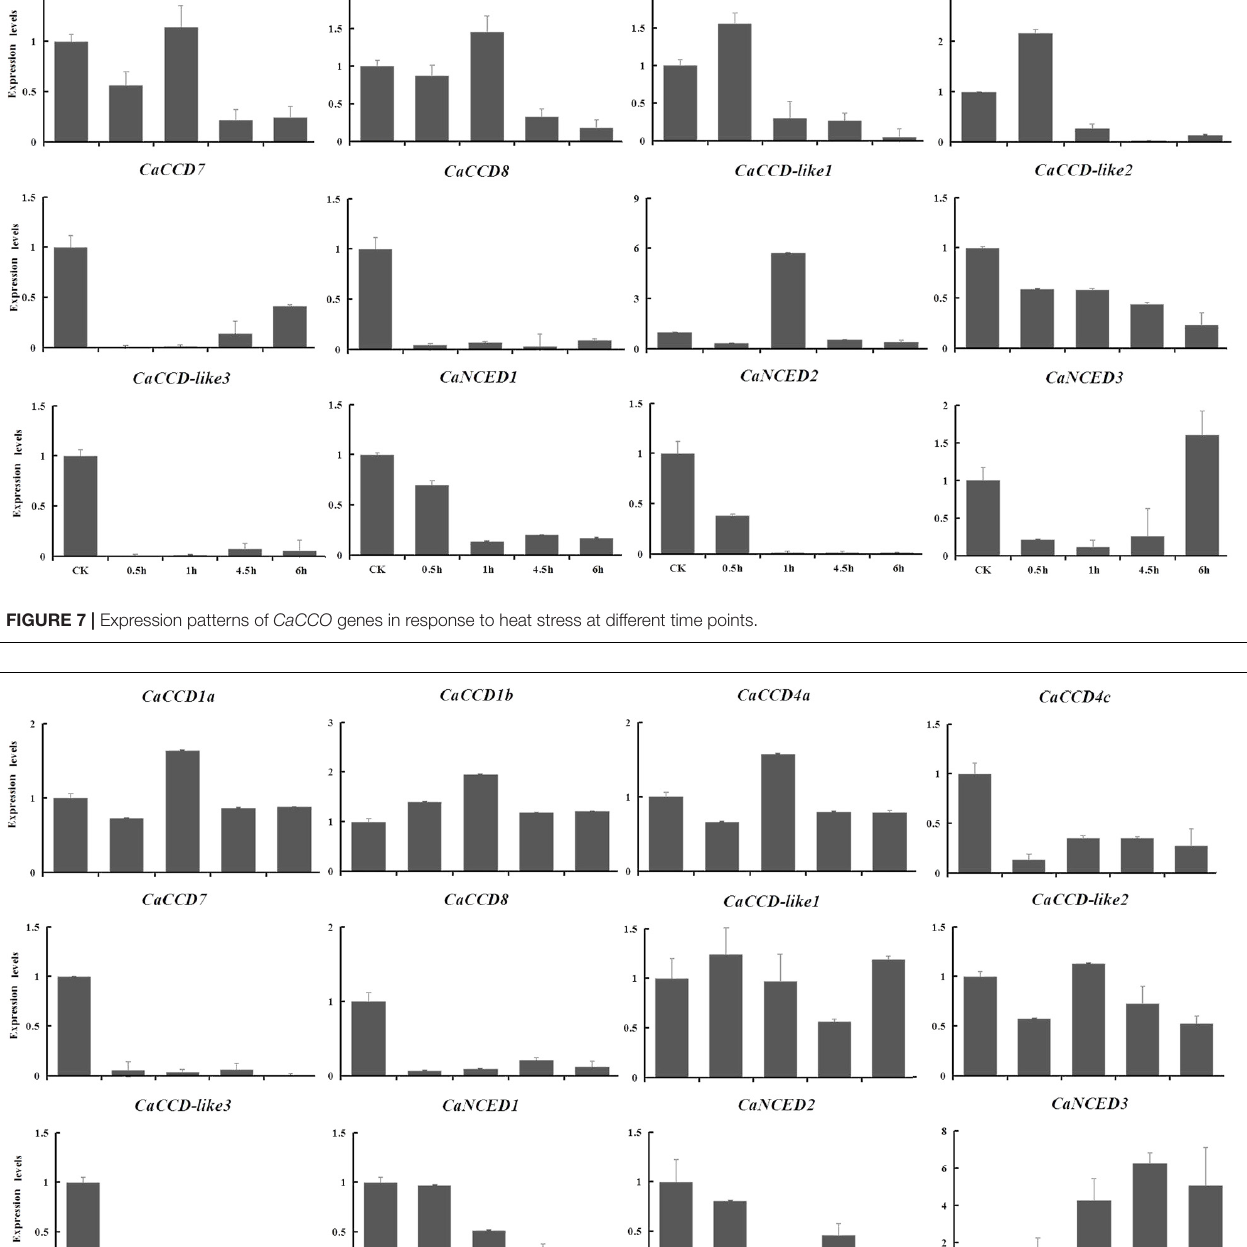
antioxidant enzymes (Gill and Tuteja, 2010). In the study, the results indicate that about half of the CCO genes can be induced by H 2 O 2 stress in both roots and leaves, and their expression levels in leaves are upregulated first and downregulated later, which may be related to ABA synthesis and stress